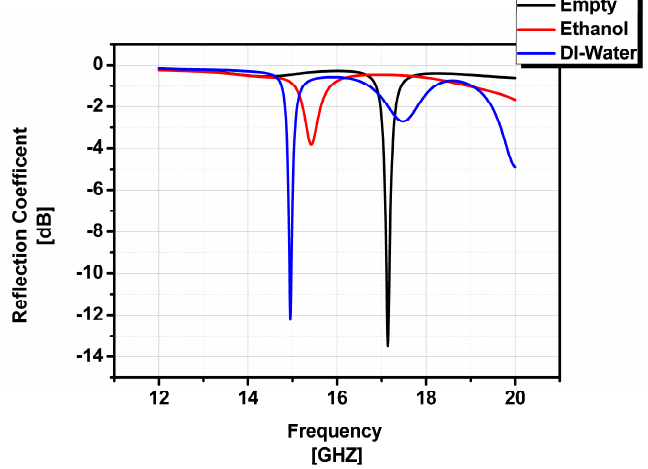
Figure 5. Simulated reflection coefficients of ethanol-filled, DI-water-filled and an empty state of microfluidic channel.